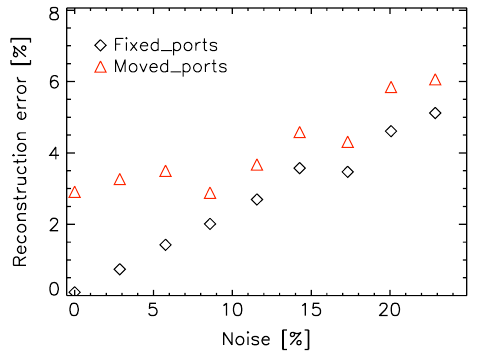
FIG. 13. Comparison of the rms error of the tomographic reconstruction as a function of the added noise level for the correct position of the fans and with the fans moved.